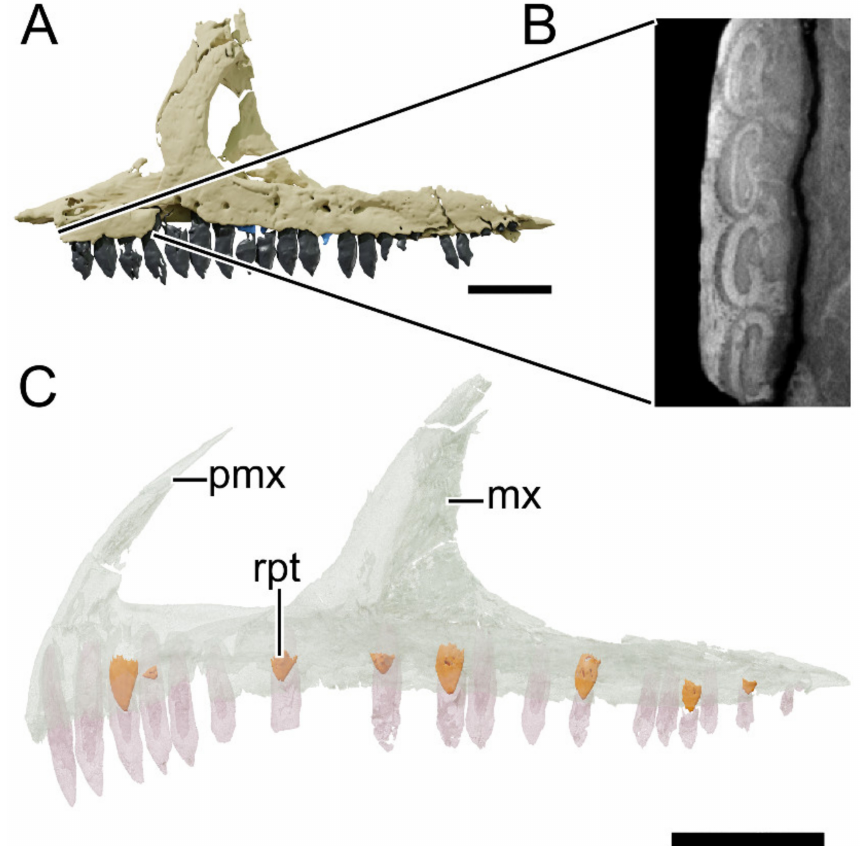
Figure 34. Digital reconstruction and CT-scan slide of the maxilla of NHMD 164741 and digital reconstruction of the right premaxilla and maxilla of NHMD 164758 in transparent display. ( A ) Digital reconstruction of the left maxilla of NHMD 164741 in lateral view. ( B ) Slice of the anterior teeth of the maxilla of NHMD 164741 showing the teeth roots in cross-section. ( C ) Mirrored reconstruction of the upper jaw of NHMD 164758. Abbreviations: mx, maxilla; pmx, premaxilla; rpt, replacement tooth. Scale bar = 50